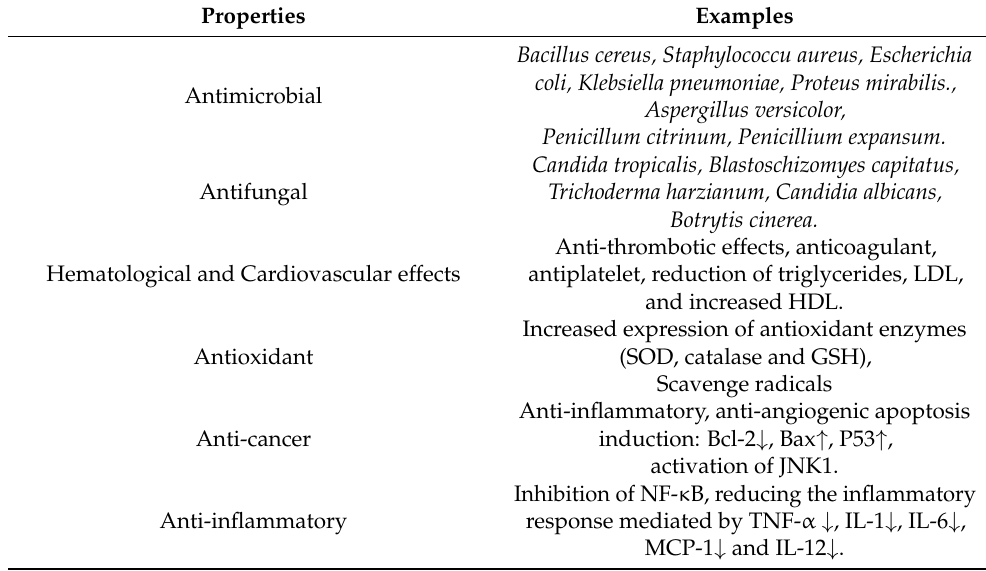
Table 1. Main properties of bioactive compounds in Aged Garlic